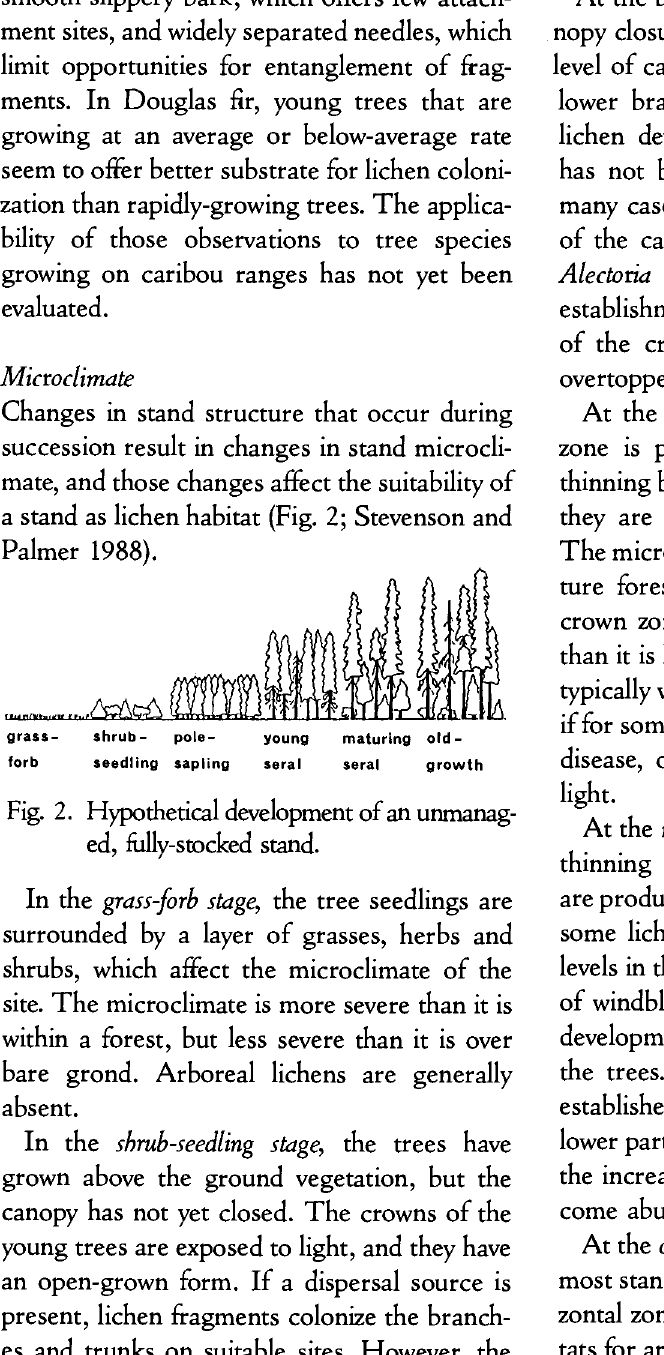
Fig. 2. Hypothetical development of an unmanag- ed, fully-stocked